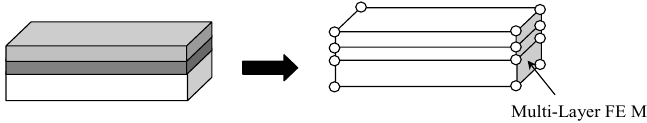
Fig. 2. Multi-layer solid element used to represent a three layer